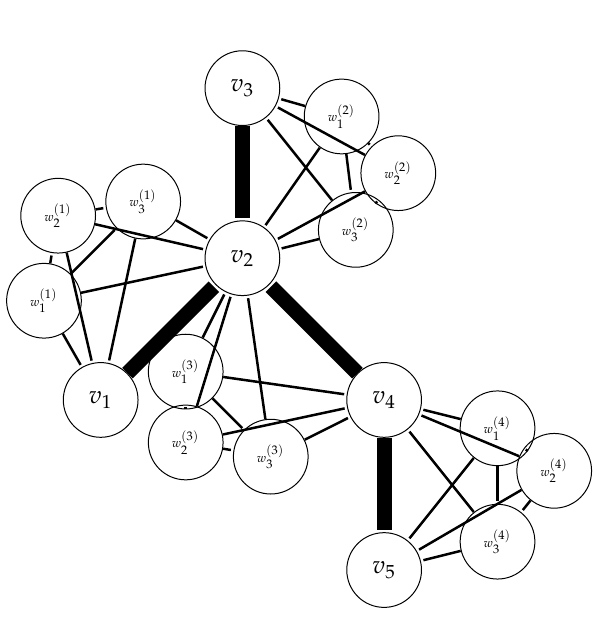
Figure 4. The graph K 5 (cid:1) H